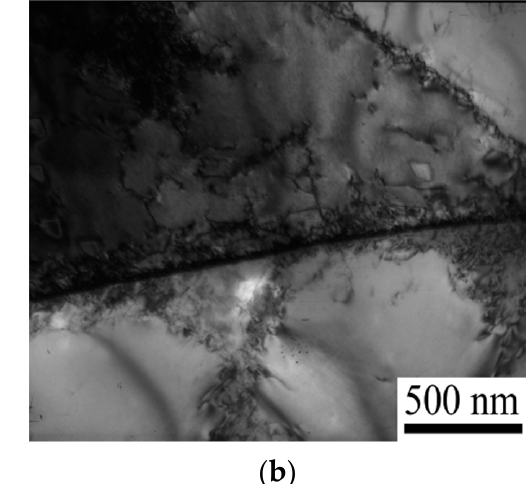
Figure 9. Microstructure of ARMCO iron after LSP and fatigue test: ( a ) EBSD IPF map and ( b , c ) TEM images; ( b ) the image was obtained in the center of the specimen and ( c ) at the surface layer and selected area diffraction pattern. The bottom edge of the EBSD map corresponds to the surface of the specimen.